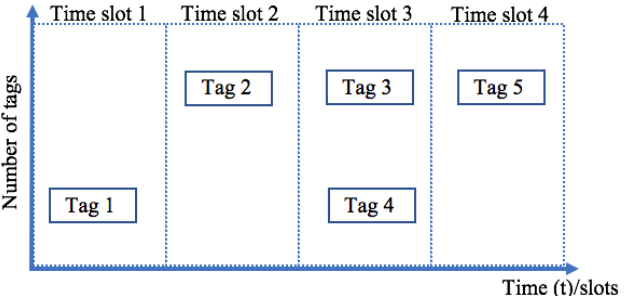
Figure 7. Time Division Multiple Access (TDMA)